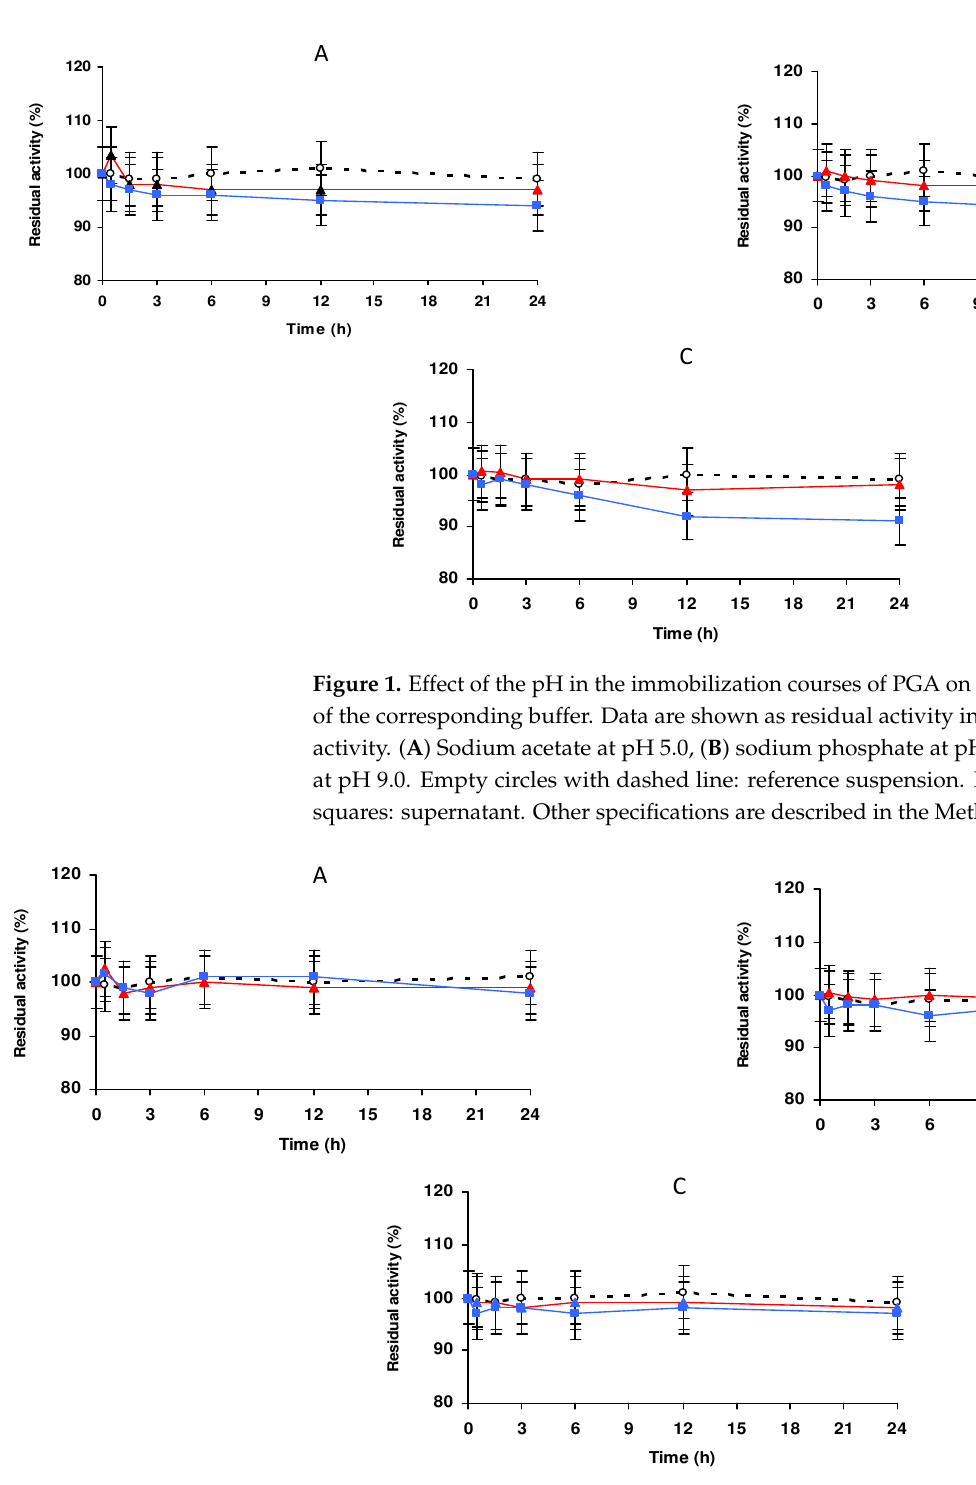
Figure 2. Effect of pH in the immobilization courses of PGA (2.5 mg/g) in agarose-MANAE beads at 25 °C in 5 mM of the corresponding buffer. Data are shown as residual activity in %, considering 100% the initial activity. ( A ) Sodium acetate at pH 5.0, ( B ) sodium phosphate at pH 7.0, and ( C ) sodium carbonate at pH 9.0. Empty circles with dashed line: reference suspension. Red triangles: suspension. Blue squares: supernatant. Other specifications are described in the Methods Section.